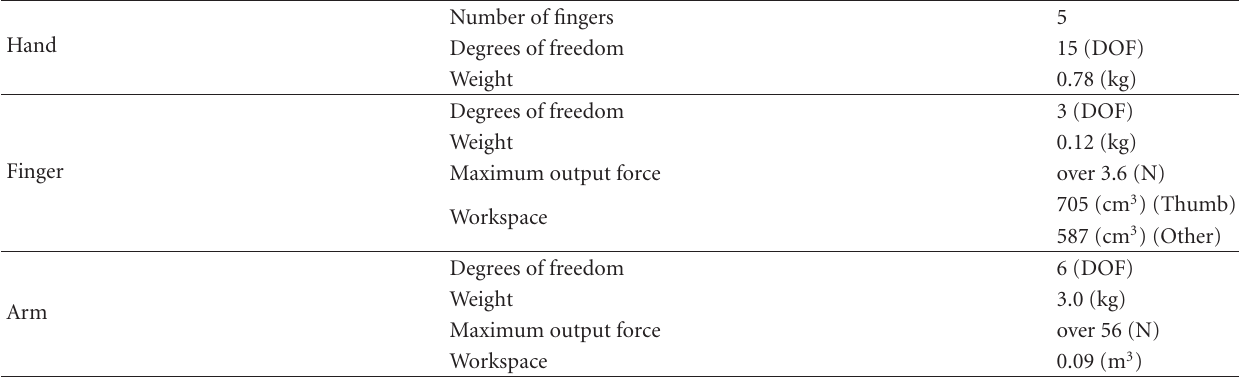
Figure 2: Finger holder and its connection. The operator wears the finger holder at his/her fingertips and connects to HIRO III as shown in (b). Table 1: Specifications of HIRO III.